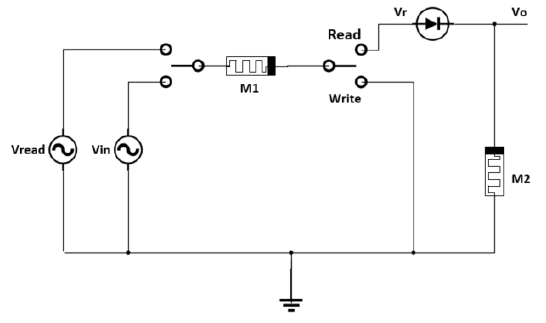
Figure 4. Nondestructive read/write circuit for memristor-based memory array (NRC) [21]. The reading signal of this scheme no longer uses the reading signal composed of positive and negative pulse signals with the same period proposed in document [18], but uses a single positive pulse signal. When the data stored in memristor are logic “1”, the memristor is in the low resistance state. At this time, the voltage Vr at the front end of the diode is close to Vread. When the diode is turned on, there is a voltage drop Vd, and the voltage drop value is about 0.7 V. Therefore, we must design an appropriate reading